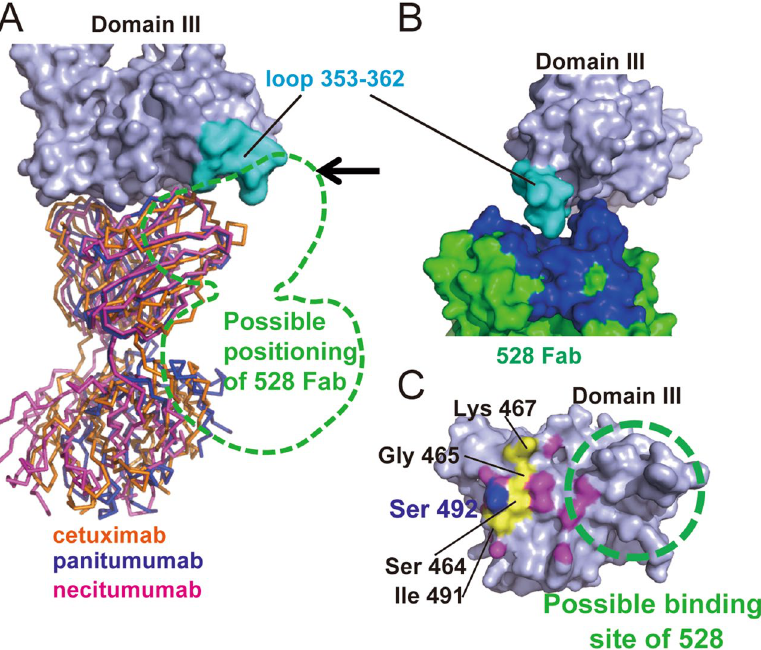
Figure 3. ( A ) Superposed anti-sEGFR antibody structure. Crystal structures of cetuximab (PDBID 1YY9, orange), panitumumab (PDBID 5SX4, blue), and necitumumab (PDBID 6B3S, magenta) antibodies complexed with domain III of sEGFR (light purple). Possible positioning of 528 Fab deduced from the electron micrograph images is indicated with a green dashed line. A black arrow indicates the viewpoint direction for ( B ). A loop comprising residues 353–362 is shown in cyan. ( B ) Manual docking model between domain III (light purple) and 528 (green). CDR loops are colored in blue and the 353–362 loop of sEGFR is in cyan. ( C ) Mutational residues of domain III induced by the cetuximab treatment (labeled with black characters). The possible binding site of 528 is indicated with a green dashed circle. Panitumumab epitope is colored with purple. The panitumumab epitope overlapping with the cetuximab-induced mutation is colored with yellow. Ser 492 is shown in